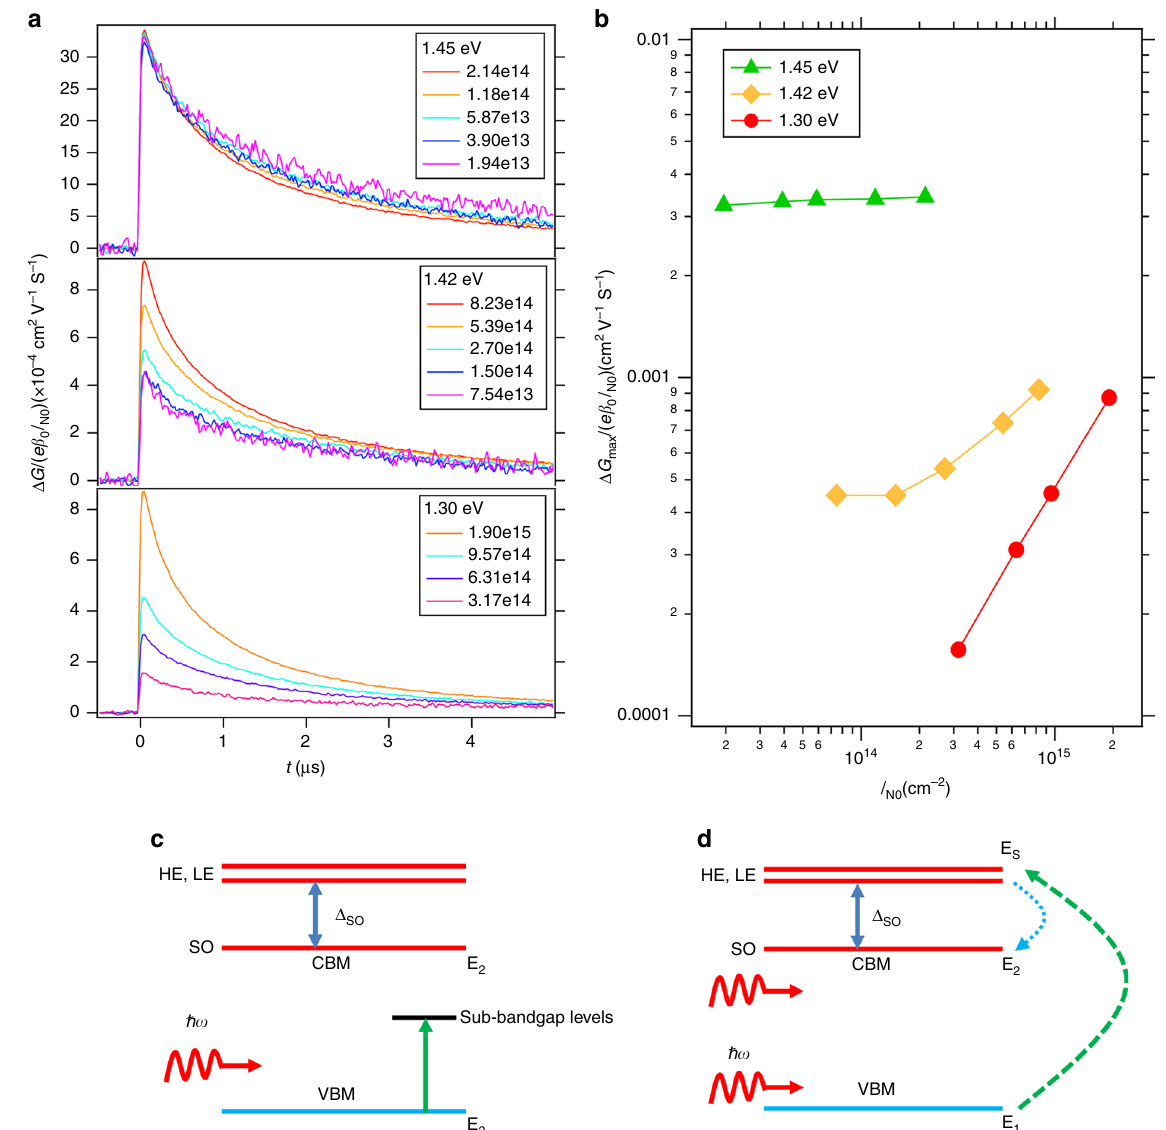
as a function of time for a CH 3 NH 3 PbI 3 fi lm measured at Fig. 1 Charge carrier dynamics and absorption processes in sub-bandgap absorption. a Δ G e β 0 I N 0 incident photon energies of 1.45 eV (top), 1.42 eV (middle) and 1.30 eV (lower). Legends show incident light intensity ( I NO ) in photons cm − 2 . versus I NO . Schematics showing generation process of charge carriers by c optical excitation from or to sub-bandgap levels (sub- b Corresponding Δ G max e β 0 I N 0 bandgap linear absorption (SLA)) and d by two-photon absorption (2PA). The initial (E 1 ) and fi nal (E 2 ) states correspond to the valence band maximum (VBM) and the conduction band minimum (CBM). The intermediate states (E s ) have been chosen for illustration as the heavy and light electron states, separated from the spin-orbit split-off (SO) states by the spin-orbit coupling ( Δ SO )